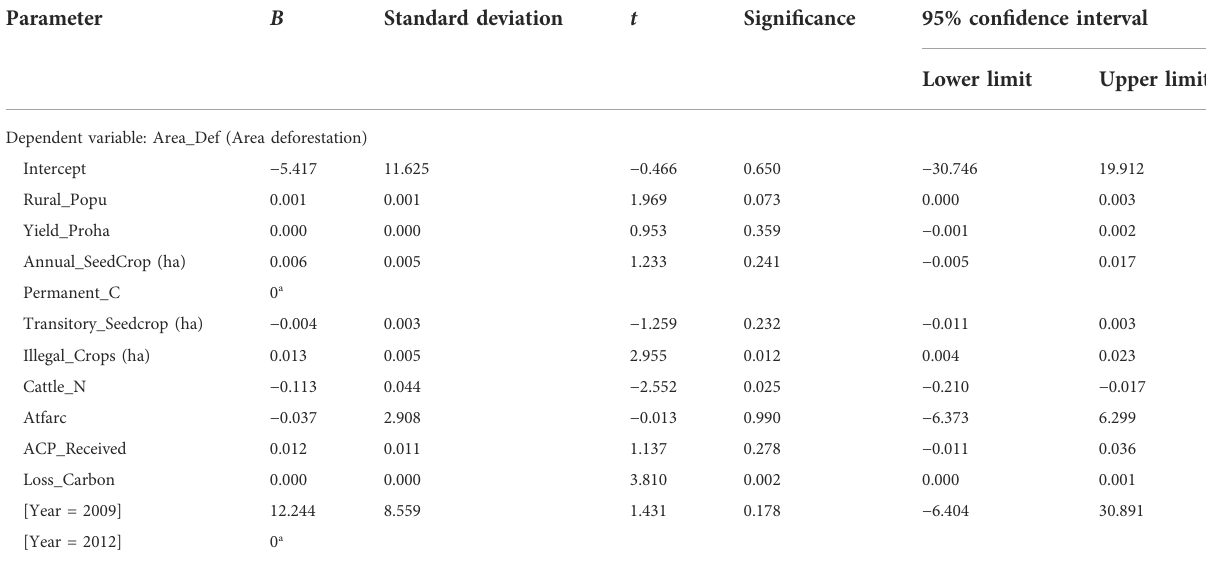
TABLE 7 Parameter estimates from the explanatory